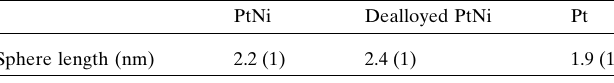
Table 3 Crystallite size of the nanoparticles determined from PDF.